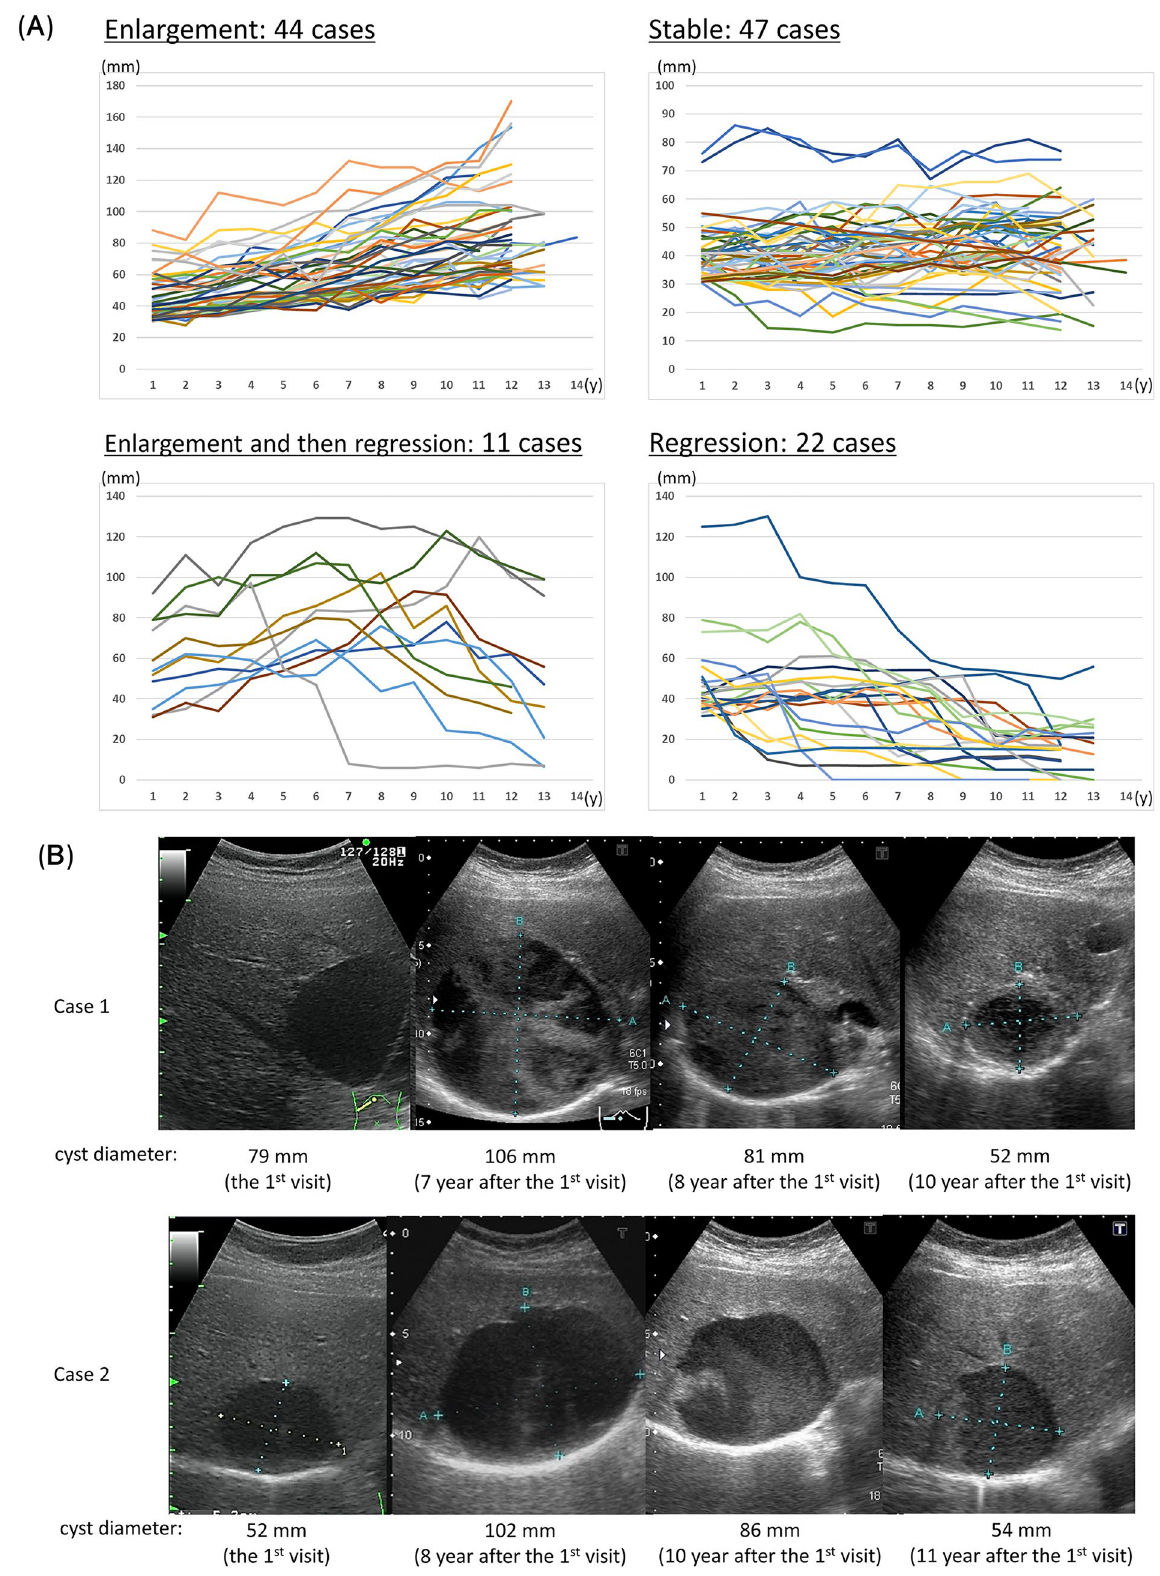
Figure 2. ( A ) Changes 10 years later in the diameter of hepatic cysts that were ≥ 31 mm at the first health checkup. ( B ) Ultrasonographic Imaging. Case 1 represents a regression case where intracystic hyperechoic fluid was observed in the seventh year followed by regression in cyst size. Case 2 represents a regression case where intracystic hyperechoic fluid was observed in the tenth year followed by regression in cyst